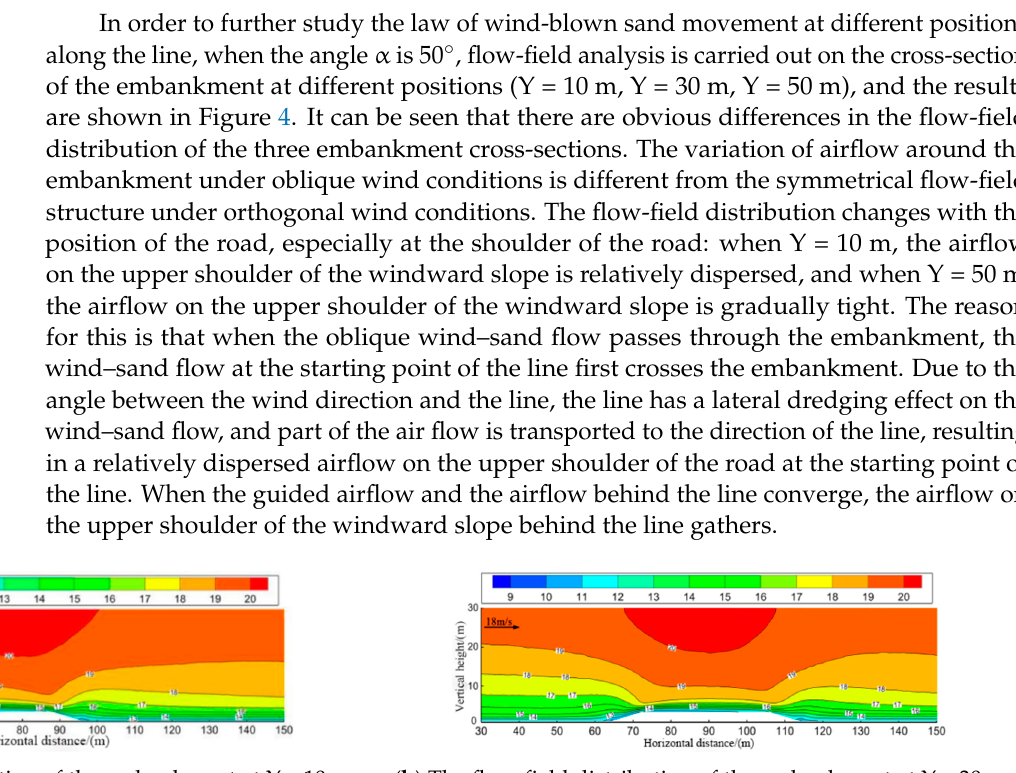
Figure 3. Flow-field distribution of embankment cross-section at different angles.